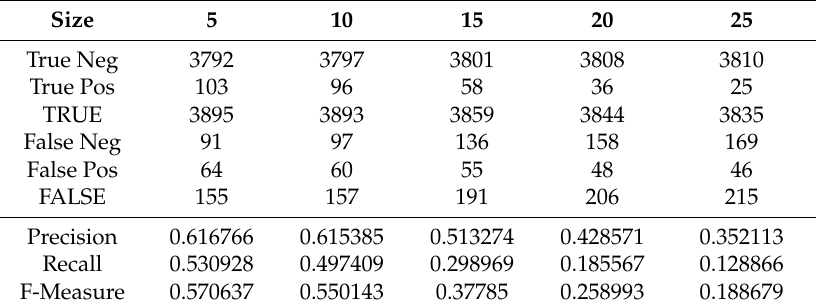
Table 5. Results of LSA output processing with the frequency